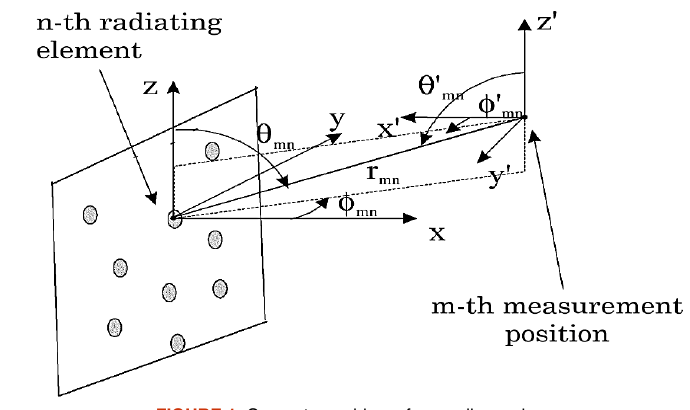
FIGURE 1. Geometry problem of array